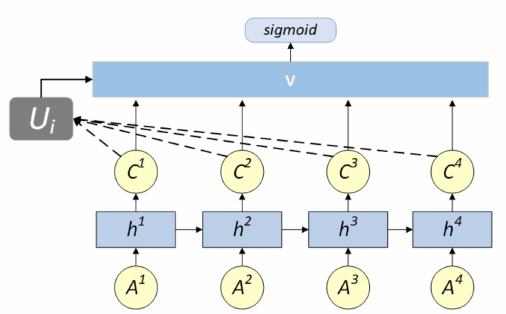
Figure 4. The KAA-LSTM takes actions step-by-step and uses key action attention to merge all the hidden states to get a final scale which represents the normative